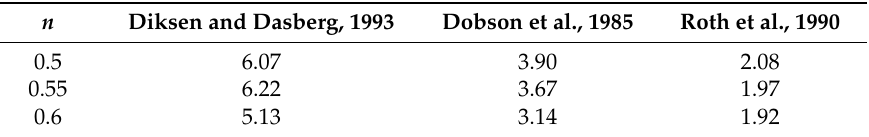
Table 4. RMSE of the models adopted to fitting the experimental